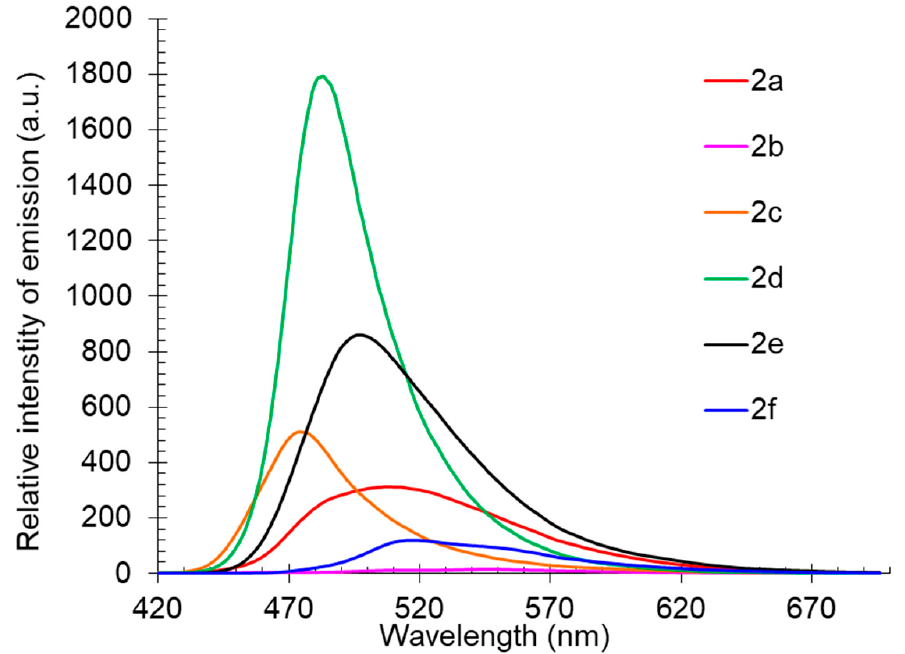
Figure 4. Solid-state photoluminescence spectra of compound 2 in a powder.